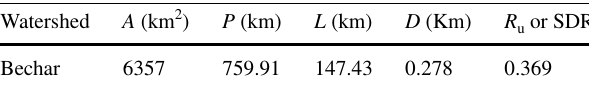
Table 5 The watershed estimated sedimentation rate by the EPM